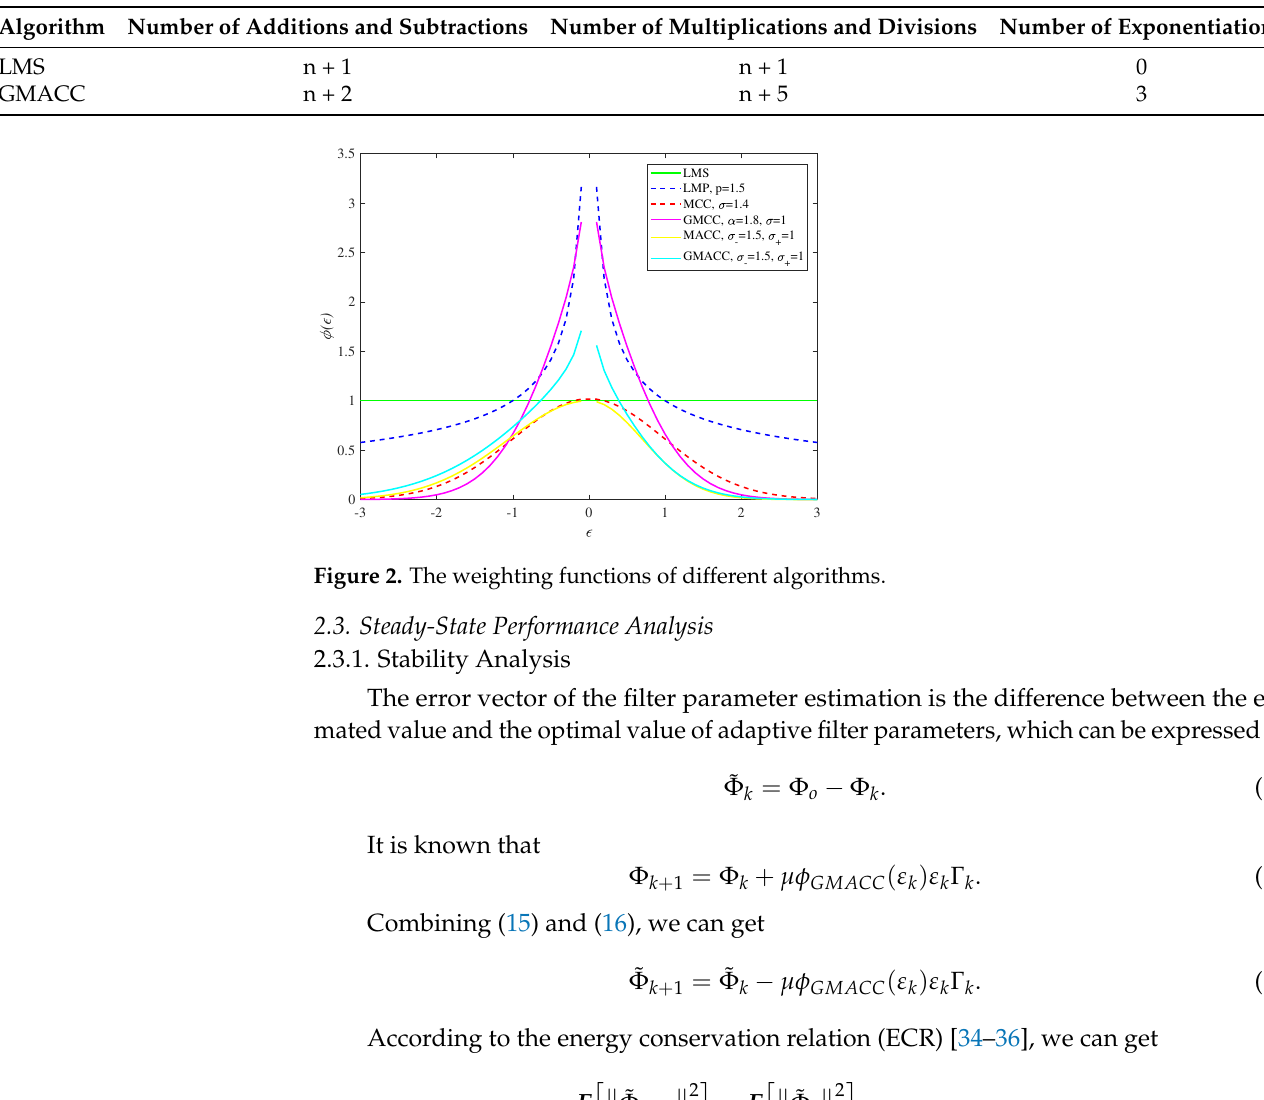
Table 1. Computational complexity (per iteration) of LMS and GMACC algorithms.